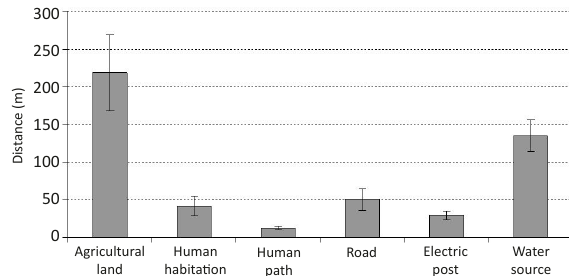
Figure 1. Mean distance to various land-use patterns observed around 22 roost sites of spotted owlets in Cauvery Delta region during December 2007 –March 2008.